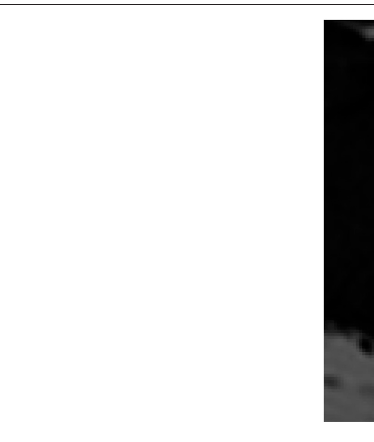
Frontiers in Bioengineering and Biotechnology |